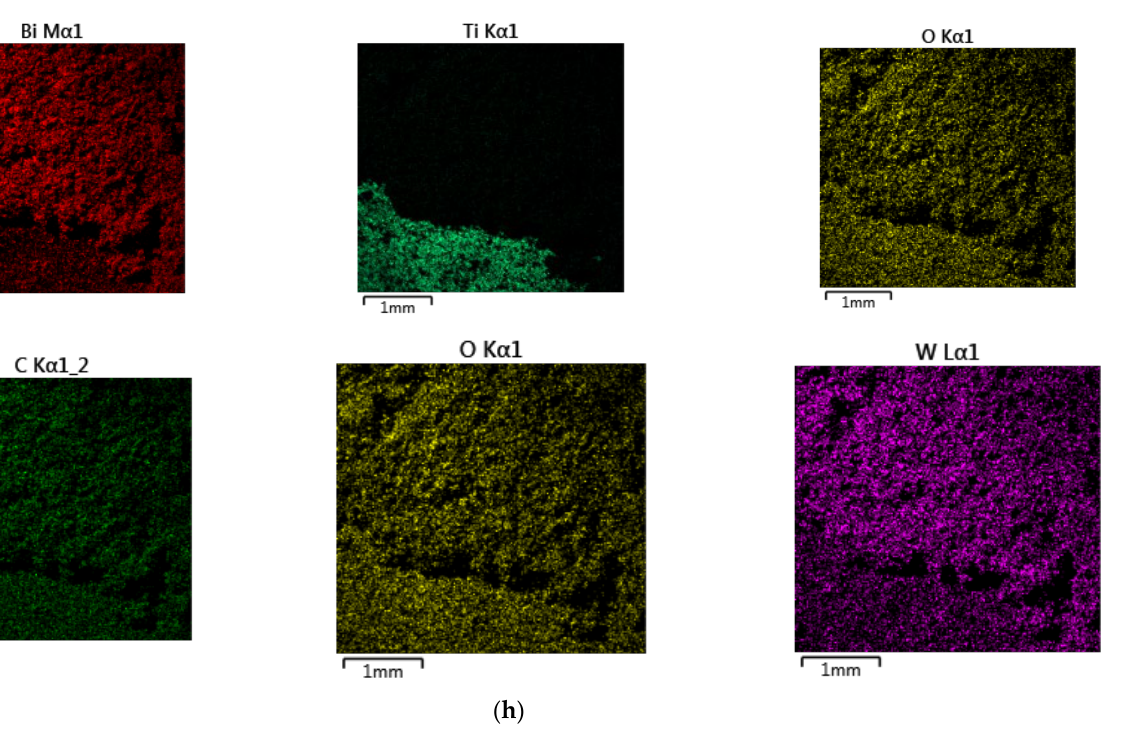
Figure 2. XRD patterns of ( a ) Bi 2 WO 6 and Bi 2 WO 6 -CNP, ( b ) TiO 2 NTA and Bi 2 WO 6 -CNP-TiO 2 NTA. FESEM images of ( c ) Bi 2 WO 6 ; ( d ) Bi 2 WO 6 -CNP; ( e ) TiO 2 NTA; ( f ) Bi 2 WO 6 -CNP-TiO 2 NTA; ( g ) EDS spectrum of Bi 2 WO 6 -CNP-TiO 2 NTA and ( h ) EDS elemental mapping of Bi 2 WO 6 -CNP-TiO 2 NTA electrode.